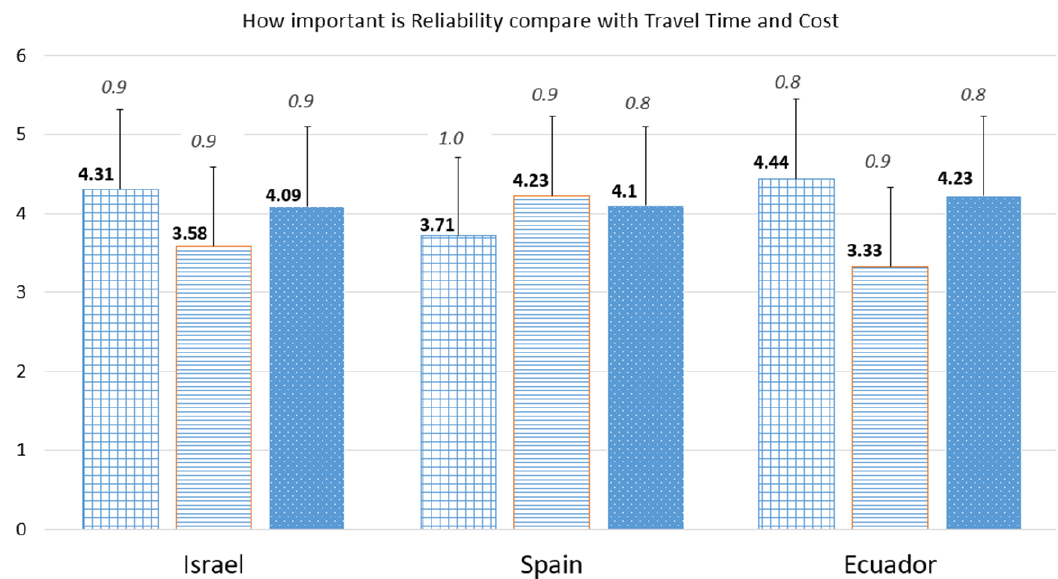
Figure 5. Comparison of Reliability vs. Travel time vs. Cost across the total sample on a scale 1–5 (1 = less important and 5 = more important).